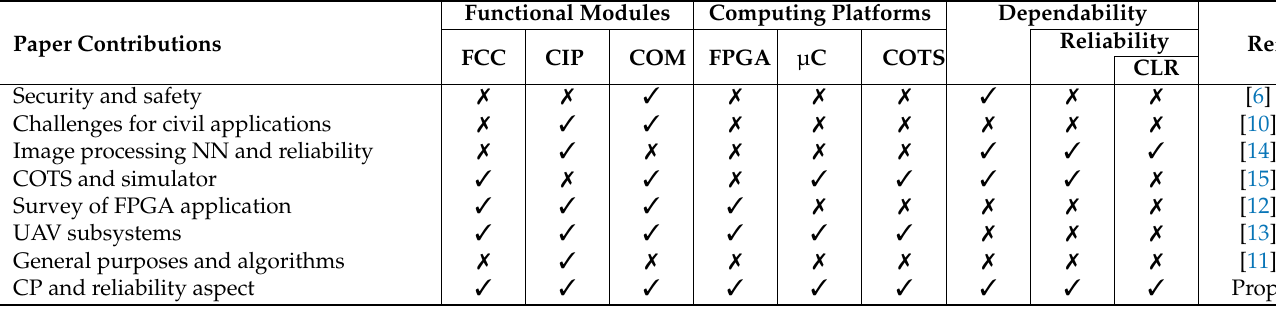
Table 1. Comparison of recent related